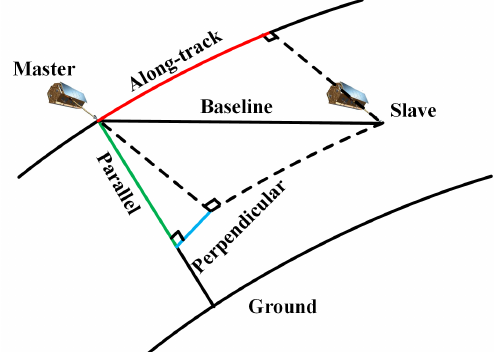
Figure 1. Vector decomposition of spatial baseline in a bistatic InSAR system. The red, blue, and green lines are along-track, perpendicular, and parallel baselines,